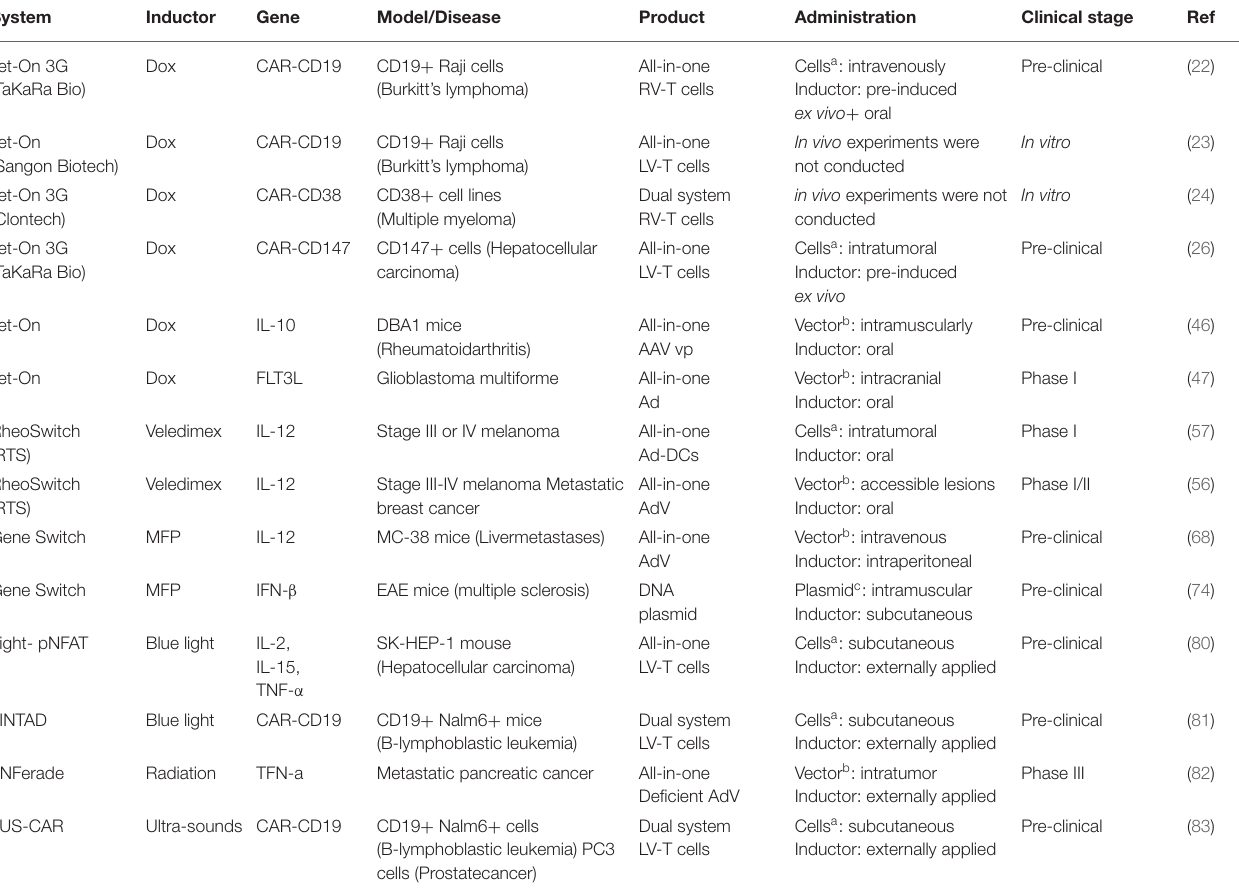
TABLE 3 | Systems for controlling transgene expression applied to immunotherapy.